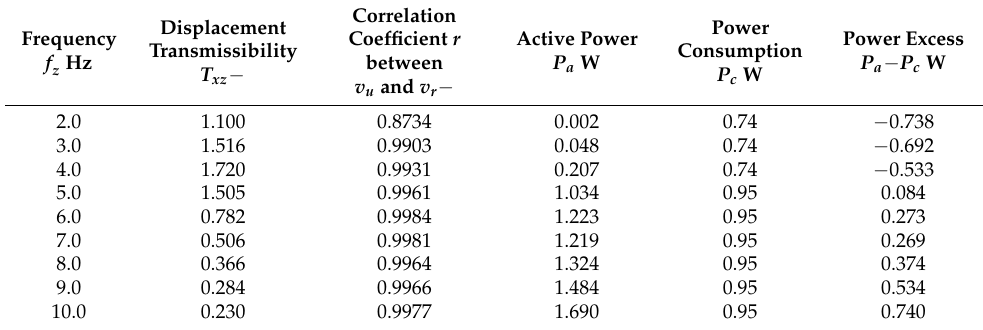
Table 4. Factors of self-sensing and self-powered operation at the various frequency in case C 5